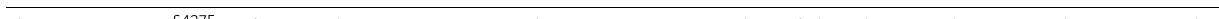
Fig. 5 PPAR γ /RXR α S427F confers partial resistance to immunotherapies. a RT-qPCR analysis of chemokines/cytokines in T24 lines engineered to overexpress RXRA-WT, RXRA-S427F, RXRA-S427Y ( upper ), and PPARG ( lower ). Controls are RXRA-WT for RXRA mutant lines and vector control (Vec) for PPARG overexpressing line. Expression normalized to GAPDH and data presented as mean fold change vs. control ± SEM of three biological replicates. b Chemokine array analysis of conditioned media collected from T24 lines engineered to overexpress PPARG (PPAR γ ) vs. control (Vec). Dotted boxes represent controls. Signi fi cant changes in secretion are outlined. One representative of three independent experiments is shown. c FACS based quantitation of in fi ltrating CD3 + CD8 + double positive T cells into subcutaneously implanted MBT2 tumors overexpressing RXRA-WT ( n = 6) or RXRA-S427F ( n = 6). Data presented as percent of total tumor-derived cells following dissociation. d Left , individual MBT2-RXR α WT tumor volumes in response to PBS ( red , n = 12) or anti-CTLA4 ( blue , n = 12). P = 0.0189 at day 7. Right , individual MBT2-RXR α S427F tumor volumes in response to PBS ( red , n = 12) or anti-CTLA4 ( blue , n = 12). P > 0.05 at day 7. One-way ANOVA followed by Tukey ’ s post-hoc test performed. e Heatmap presenting pathway level analysis (activation, red ; suppression, blue ) of differentially expressed genes in PPAR γ knockdown lines (PPAR γ -sh#4 and -sh#9 engineered in SV-HUC-1 line expressing RXRA- S427Y) relative to vector control. The analysis was based on three biological replicates. f Left , Knockdown of PPAR γ or RXR α by shRNAs in HT-1197 cells. GAPDH was used as the control. Right , RT-qPCR analysis of in fl ammatory genes CCL2 and CXCL10 following inducible knockdown of PPAR γ and RXR α in HT-1197 cells. Data normalized to GAPDH and presented as mean fold change (Dox treated vs. untreated) ± SEM of three biological replicates. g RT-qPCR analysis of IL8 and CCL2 following treatment with PPAR γ agonist rosiglitazone (Rosi) or PPAR γ antagonist T0070907 in 5637 cells. Data normalized to GAPDH and presented as mean fold change ± SEM of three biological replicates. h Schematic representation of the role of tumor-intrinsic PPAR γ